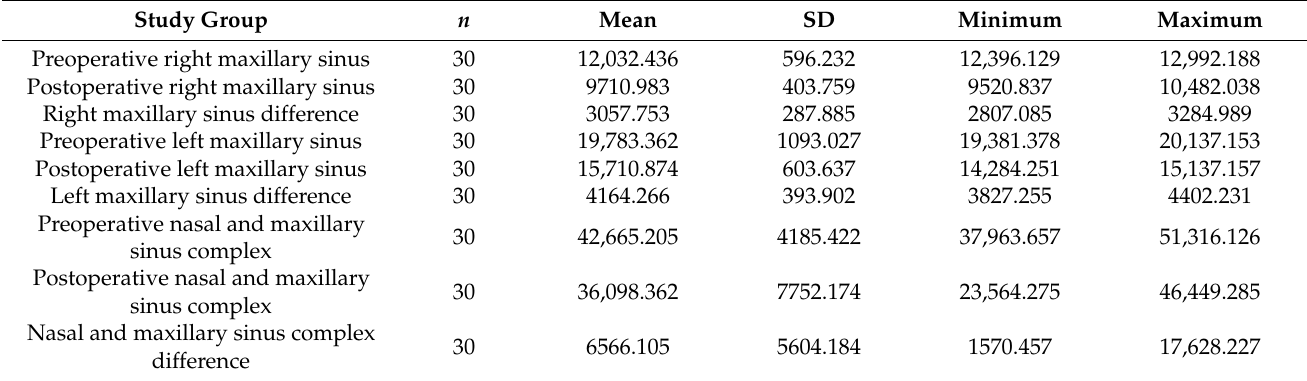
Table 1. Descriptive statistics of the preoperative and postoperative volumes of the right maxillary sinus (mm 3 ), left maxillary sinus (mm 3 ), and nasal and maxillary sinus airway complex after sinus lift using the lateral window approach technique.